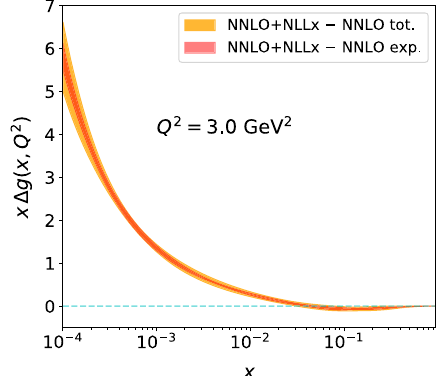
Fig. 4 Thedifference betweenthegluondistributiondeterminedinthe fits at NNLO with and without NLLx resummation taking into account the correlations betweentheiruncertainties. The orange (red) band indi- cates the full (experimental) uncertainty on the difference